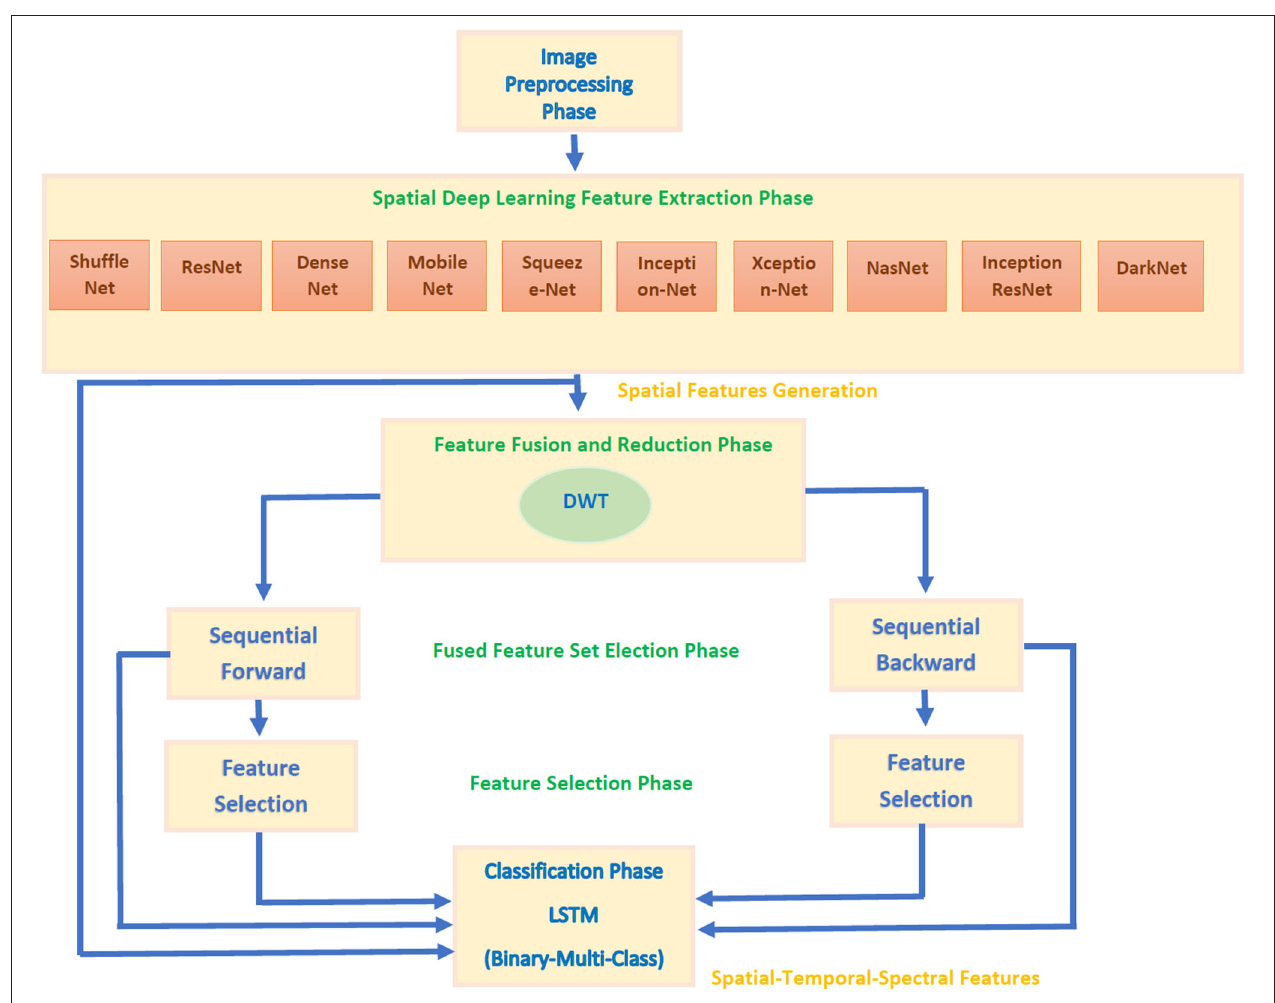
FIGURE 2 | The block diagram of CoMB-Deep